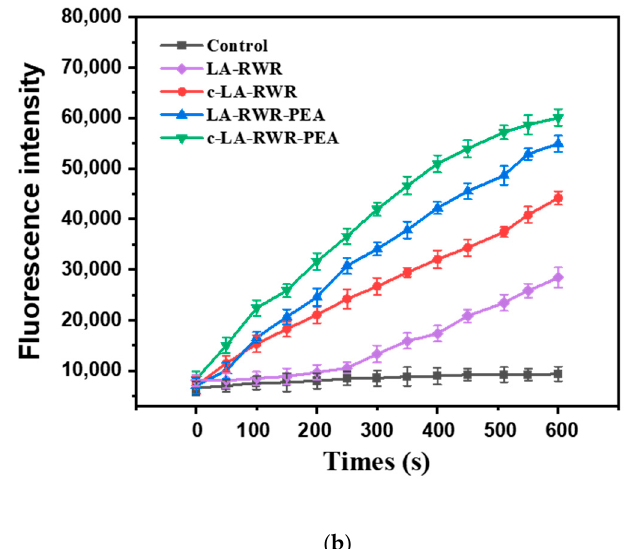
Figure 6. ( a ) Cytoplasmic membrane depolarization and ( b ) outer membrane permeability of E. coli treated with LA ‐ RWR, c ‐ LA ‐ RWR nanoparticles, LA ‐ RWR ‐ PEA, and c ‐ LA ‐ RWR ‐ PEA nanoparticles at 2MIC concentration for 10 min, respectively.